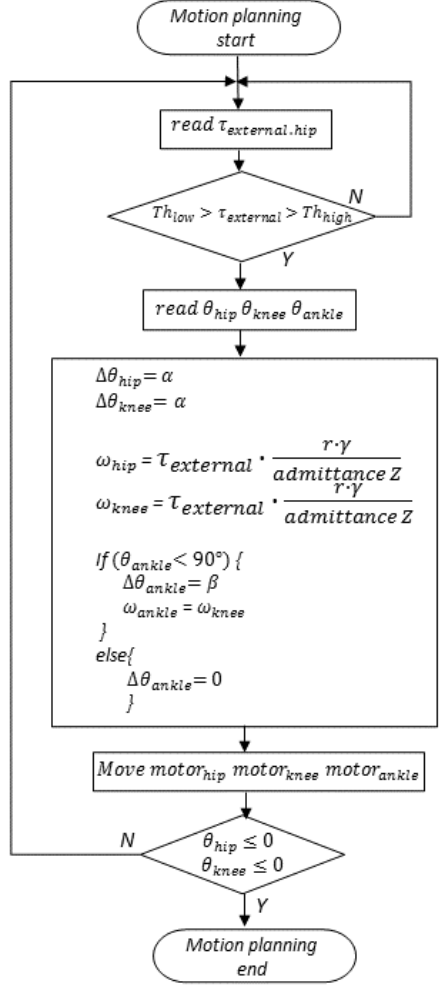
Figure 8. Motion planning of robot’s lower limbs.